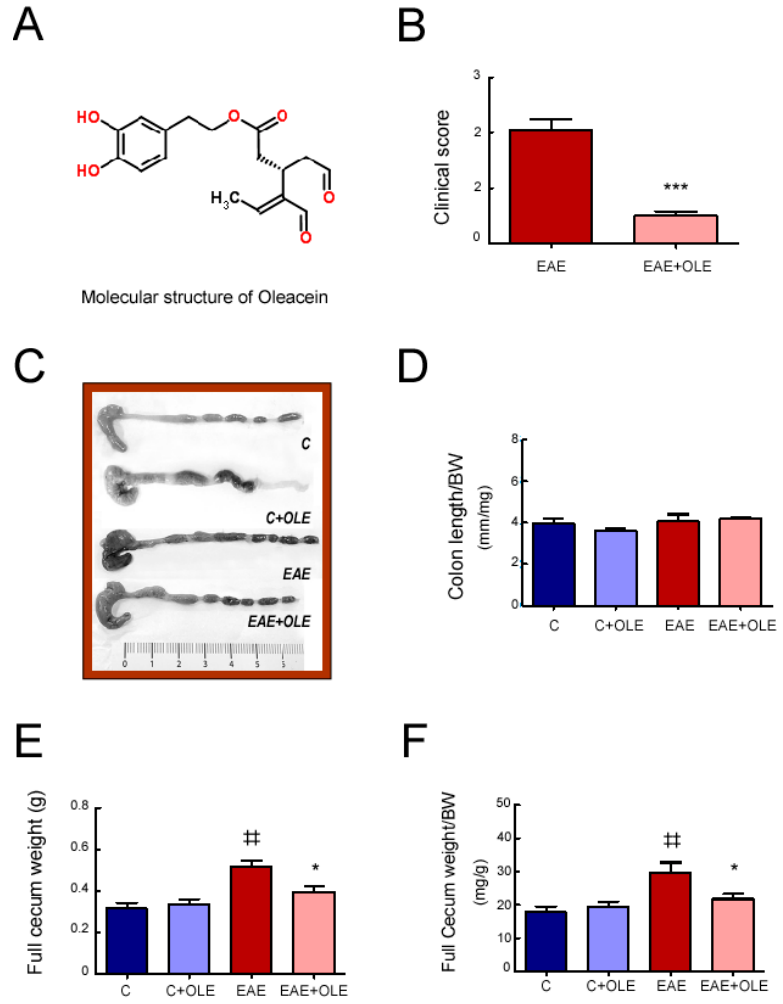
Figure 1. Effect of OLE treatment on colon length and cecal parameters in EAE mice. ( A ) Schematic representation of OLE; ( B ) Maximal scores; ( C ) Representative image of colons; ( D ) colon length/body weight (BW) ratio; ( E ) full cecum weight; ( F ) cecal index: full cecum weight/body weight (BW) ratio. Results were expressed as the mean ± SEM, n = 5–7 per group. ‡‡ p < 0.01 vs. control; and * p < 0.05 and *** p < 0.001 vs. untreated-EAE. C, healthy mice. C + OLE, healthy mice treated with OLE. EAE, induced mice. EAE + OLE, induced mice treated with